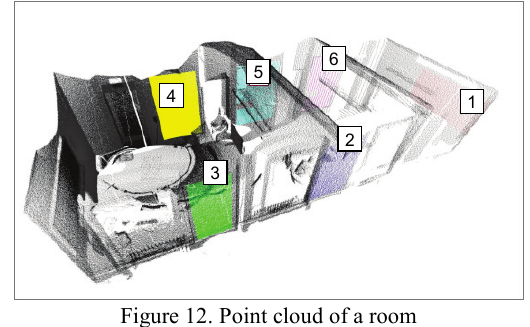
Figure 12. Point cloud of a room